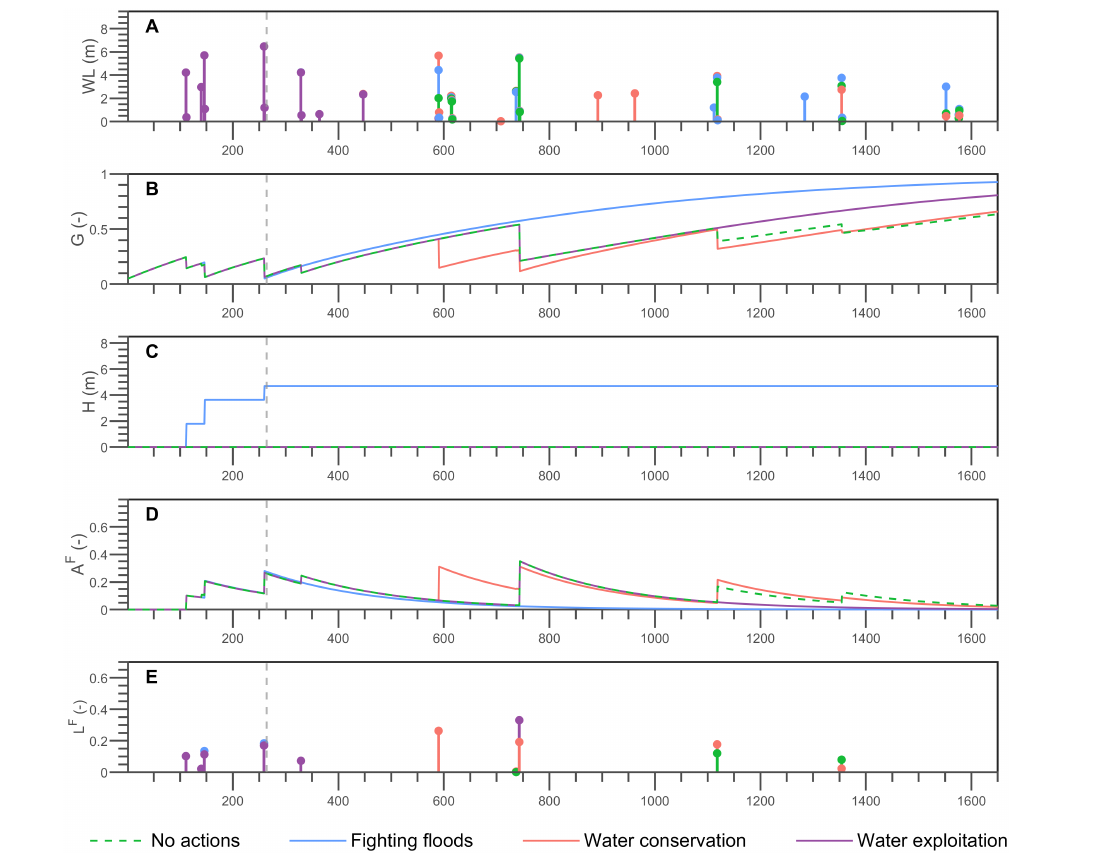
Fig. 8 . Flooding-based variables of the synthetic numerical experiments considering dam construction and human-flood interactions with the four water-management strategies introduced in this study. (A) Water level (WL), (B) proportion of population in floodplain (G), (C) levee height (H), (D) flood awareness (A F ), and (E) flood losses (L F ). The gray dashed line indicates the construction of the Wivenhoe